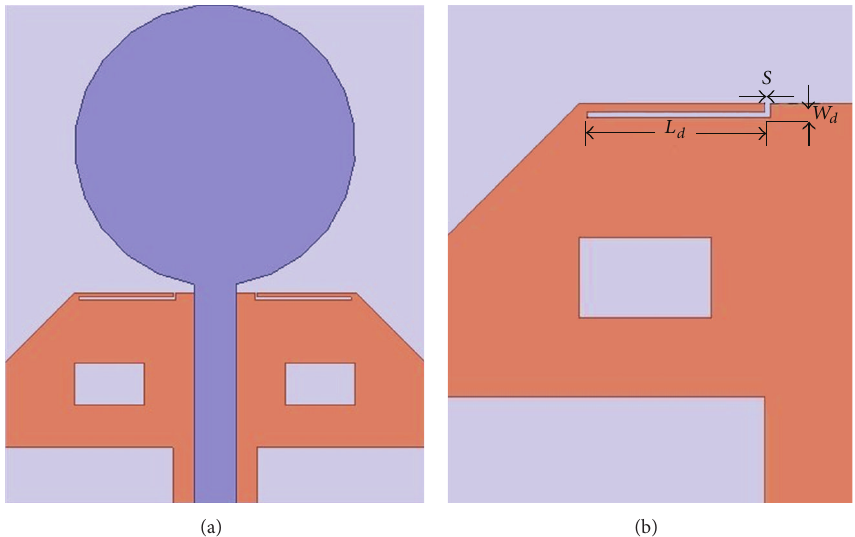
Figure 7: Geometry of the high frequency band-notched antenna: (a) top view, (b) narrow slot on the ground plane.